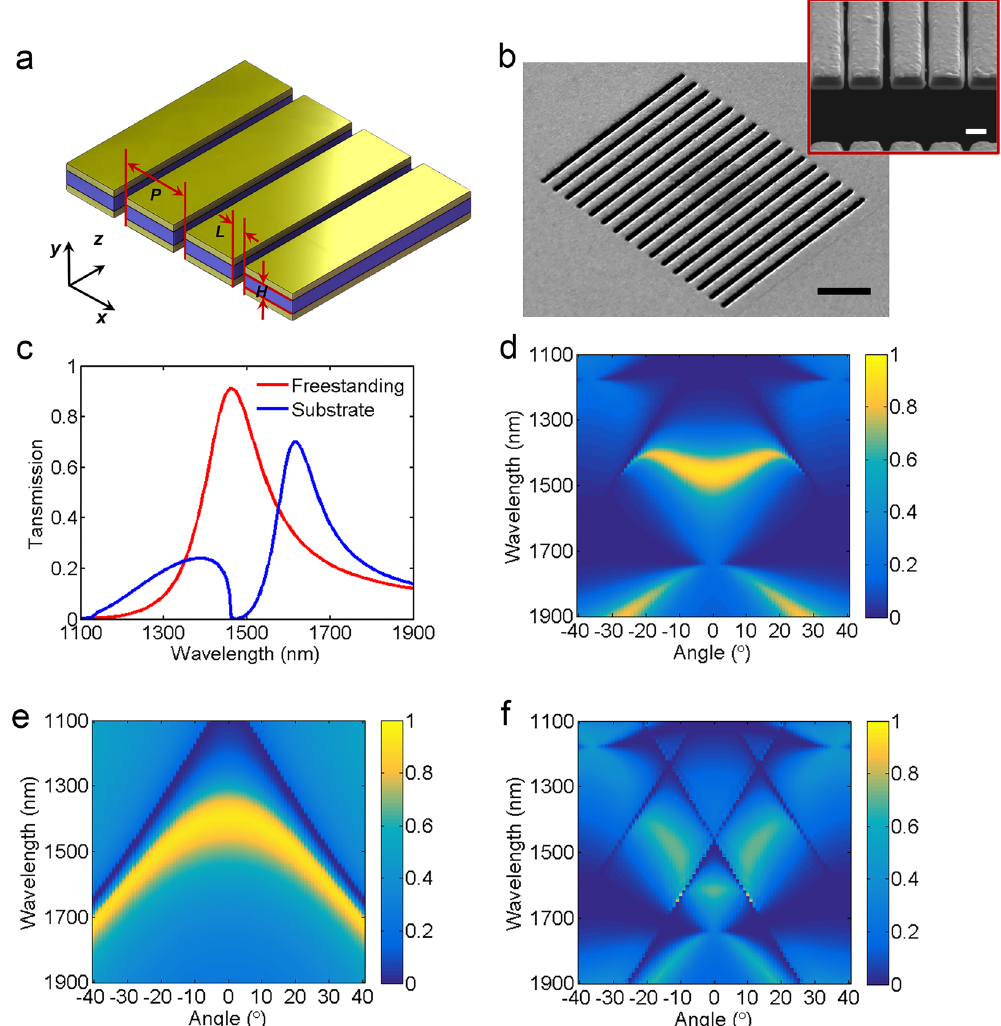
Figure 1. Plasmonic bandpass filter constructed by free-standing MDM stack array. ( a ) Schematic diagram of the free-standing MDM stack array. The Si 3 N 4 dielectric layer is sandwiched in between Au layers. The periodicity ( P ) and slit width ( L ) of the array is 1000 nm and 250 nm. The thickness of Si 3 N 4 dielectric layer and Au layers is 250 nm and 90 nm, respectively. ( b ) Scanning electron microscopy images of the fabricated device. Scale bar, 4 μ m. Inset shows magnified cross-section view. Scale bar, 500 nm. ( c ) Comparison of calculated transmission spectra for the free-standing structure and the structure with substrate. Calculated transmission diagrams as a function of incident angle and wavelength for ( d ) the free-standing MDM stack array, ( e ) the free- standing single layer metallic grating, and ( f ) the MDM stack array with